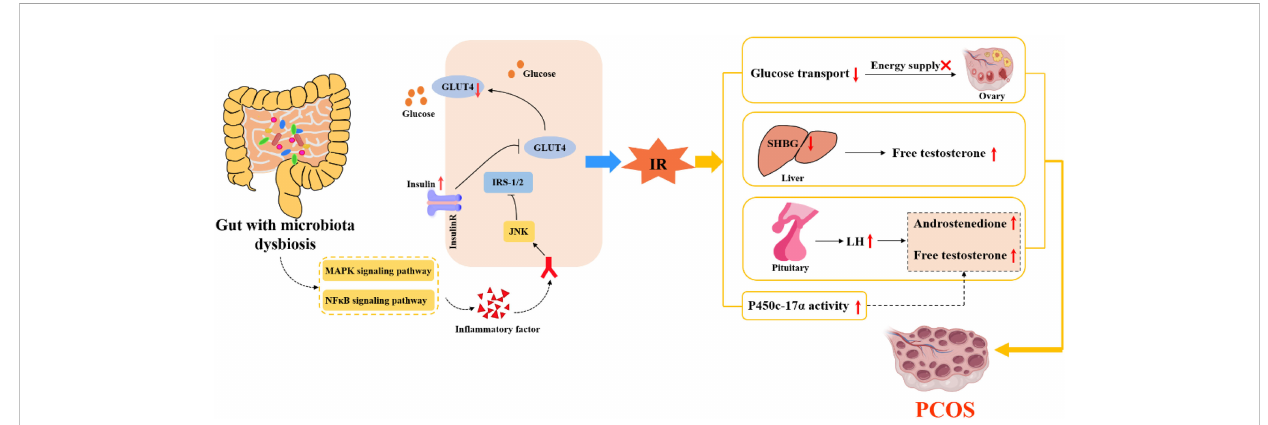
FIGURE 2 The internal relationship between IR, intestinal fl ora and